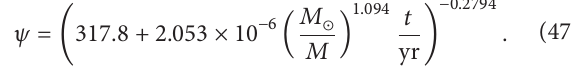
unity in the range 0 < 𝜓 < 0.1 and integrate (46) in the above limit to